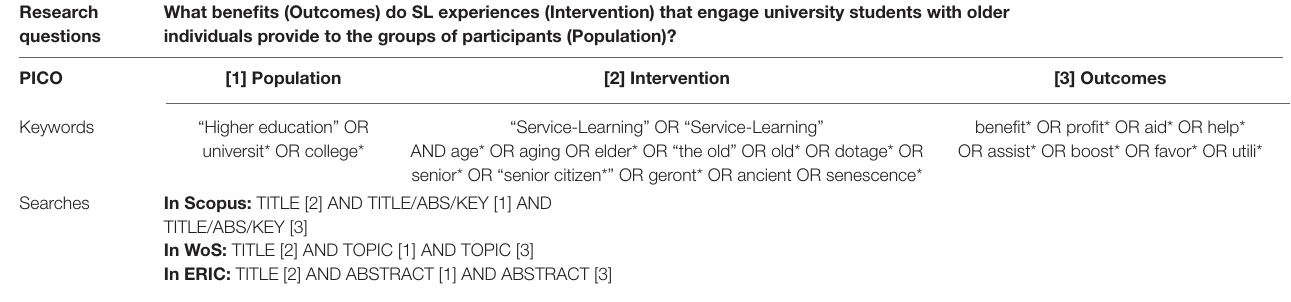
TABLE 1 | Research questions and keywords formulated with PICO